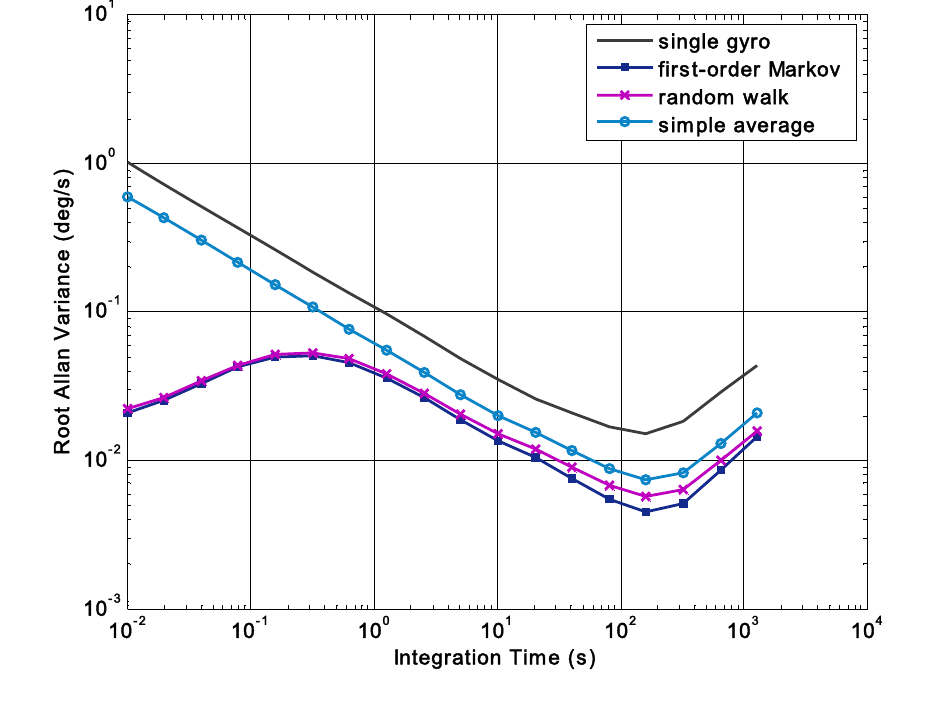
Figure 6. Allan variance results of the virtual gyroscope compared to the single gyroscope and averaging outputs of the gyroscope array.